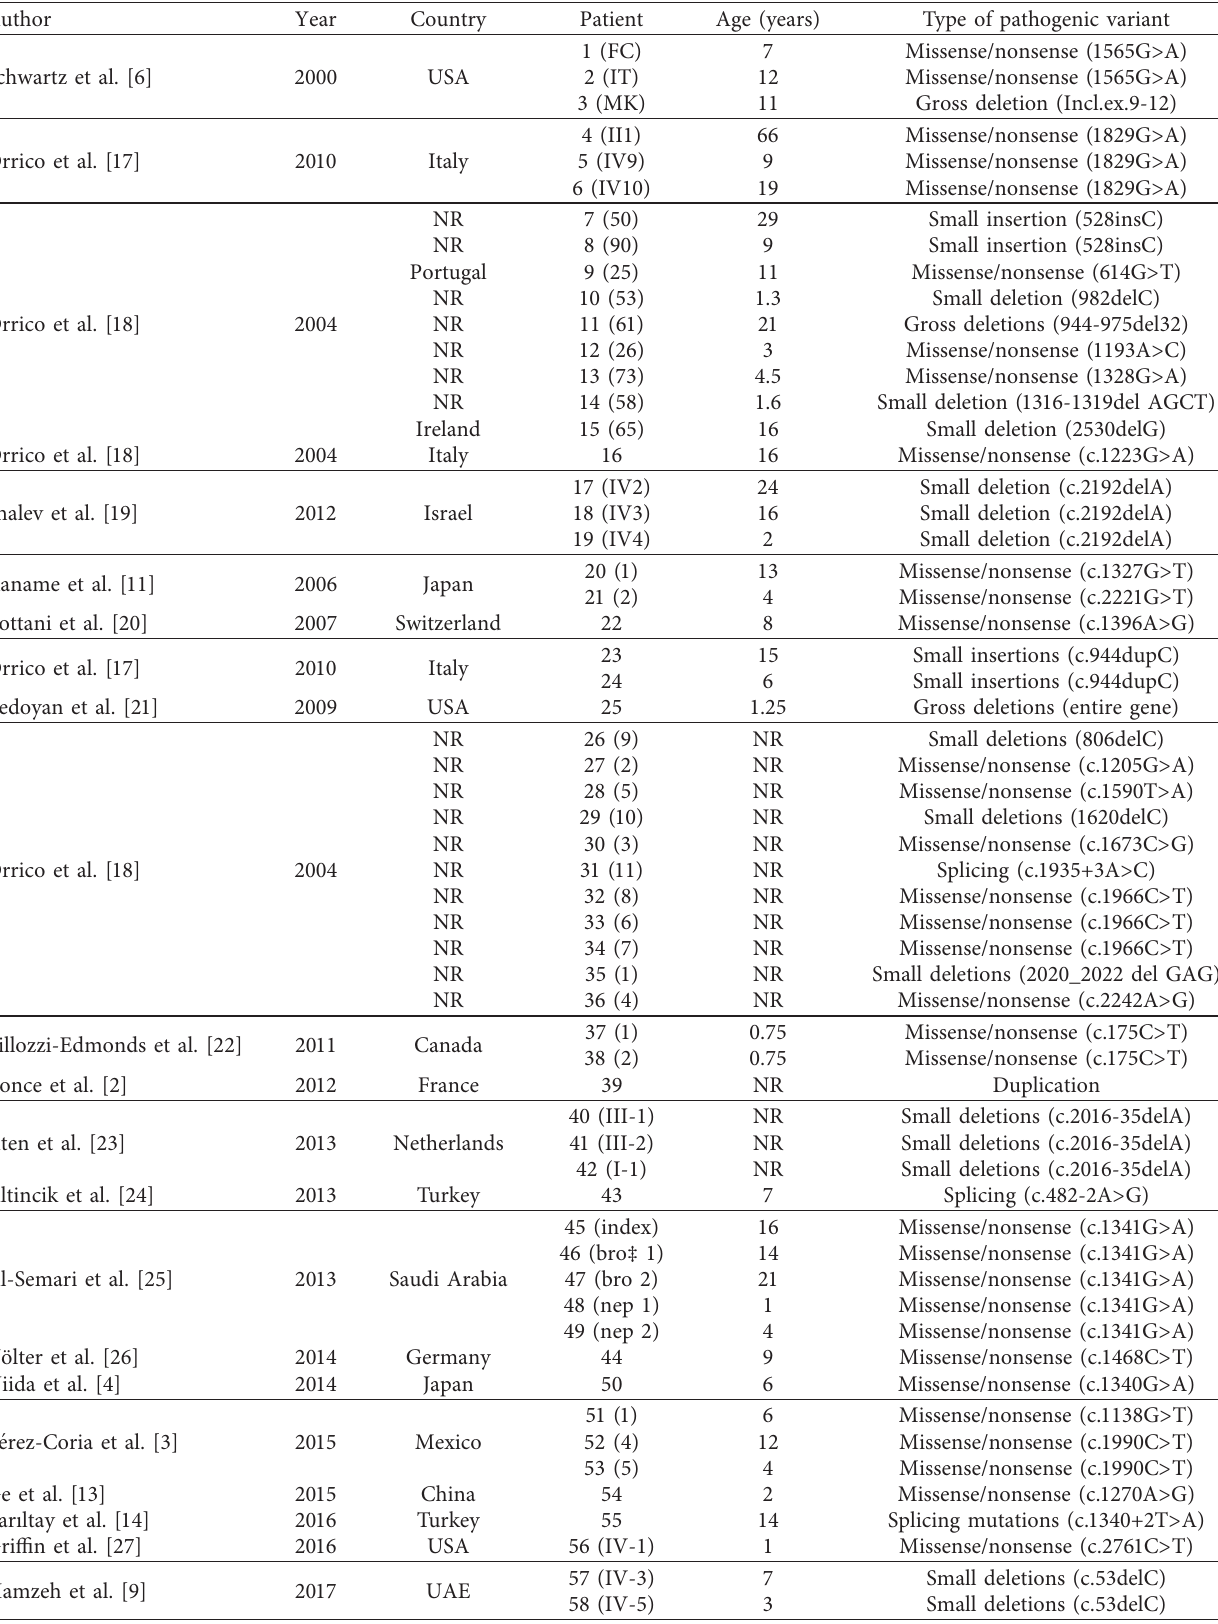
Table 1: General information collected from case reports with genetic testing